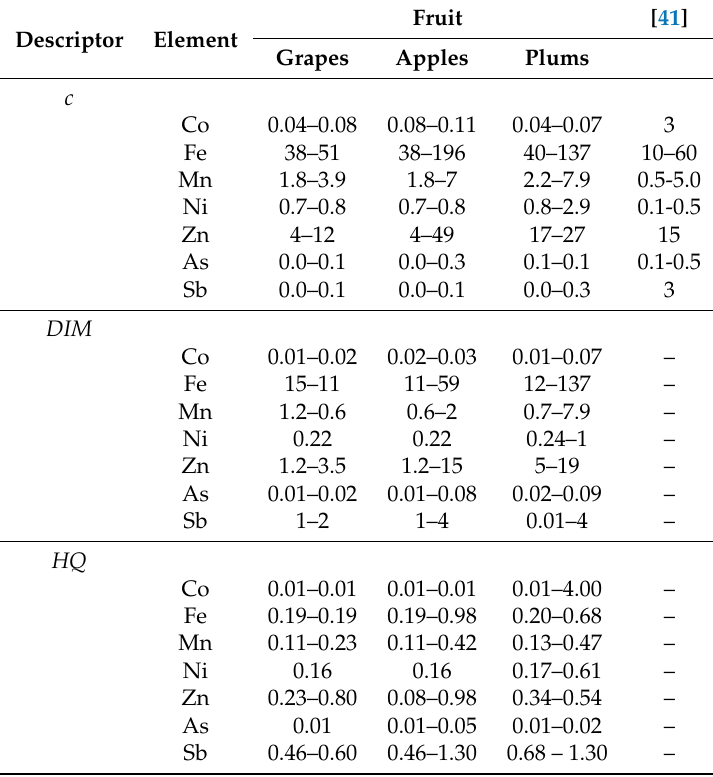
Table A4. The interval of the values of mass fraction c (fresh weight, in µ kg − 1 ), Daily Intake of Metal ( DIM ) (in g kg − 1 ), as well as of the Hazard Quotient ( HQ ). For comparison, the corresponding fresh weight content recommended by the World Health Organization [41] is